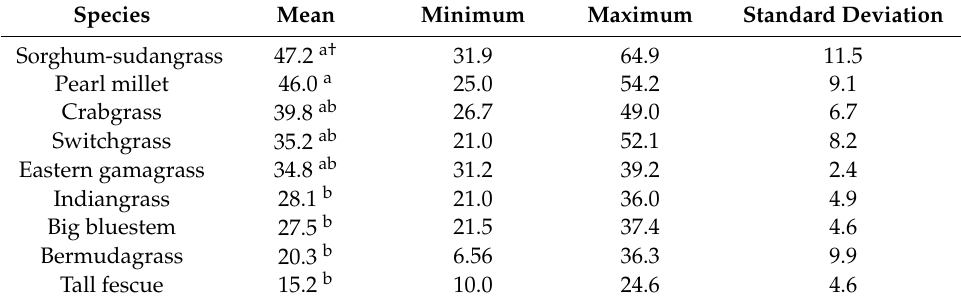
Table 1. Least square means of iWUE ( µ mol CO 2 mol H 2 O − 1 ) by species in the greenhouse experiment across four sampling dates, for both dry and wet treatments, University of Tennessee, Knoxville, TN, 2013 ( n =